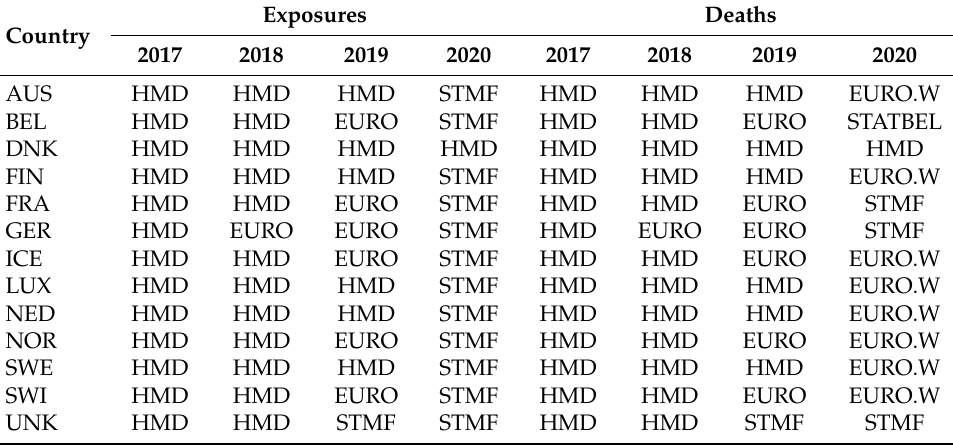
Table A1. Overview of the data sources used for each country in the stochastic multi-population mortality projection model of type Li and Lee. The data sources ‘HMD’, ‘EURO’ and ‘STATBEL’ refer to the Human Mortality Database, Eurostat and the Belgian statistical institute Statbel,